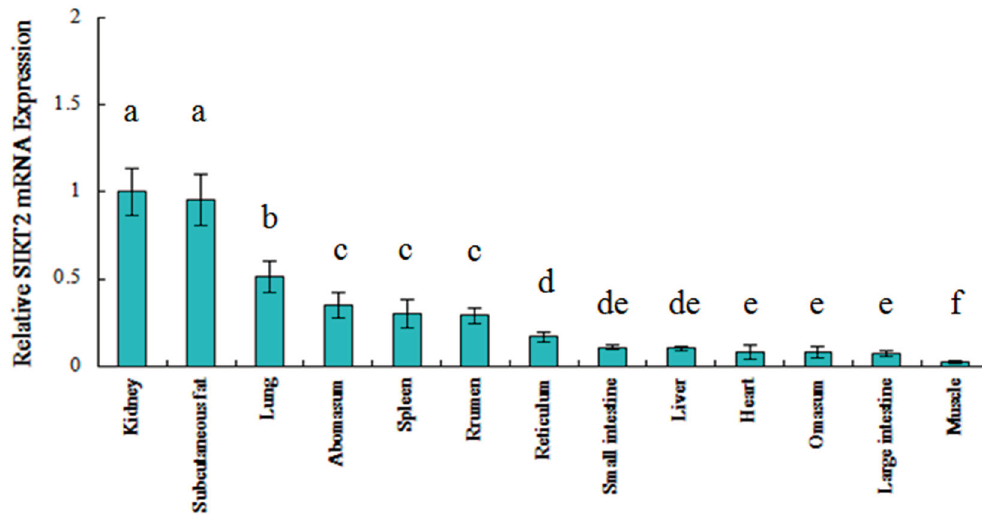
Figure 2. Tissue expression analysis of SIRT2 mRNA in Qinchuan cattle. Different lowercase letters above the bars (a–f) indicate significant difference between tissues ( p <